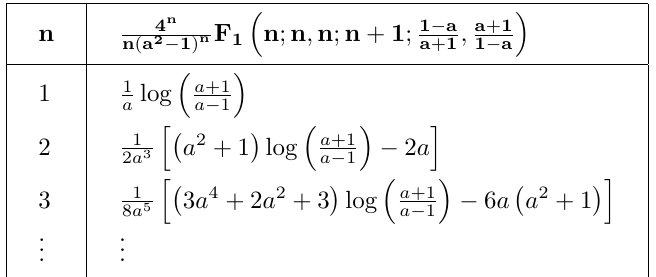
Table 1 . Functional form of the integral (F.13) for few integer n